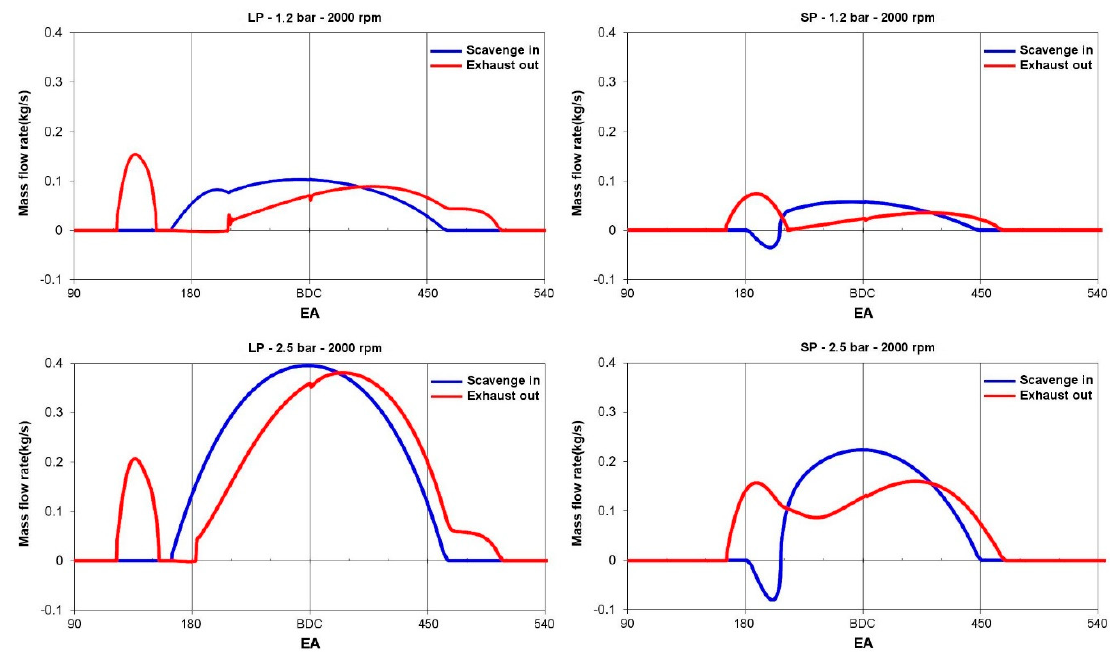
Figure 11. Comparison of scavenge and exhaust port flow rates at different charging pressures for LP and SP geometry.